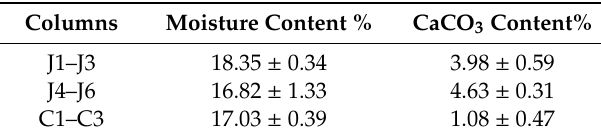
Table 8. Moisture and CaCO 3 contents of biocemented columns (averages from Table 8. Column parameters and CaCO 3 contents.